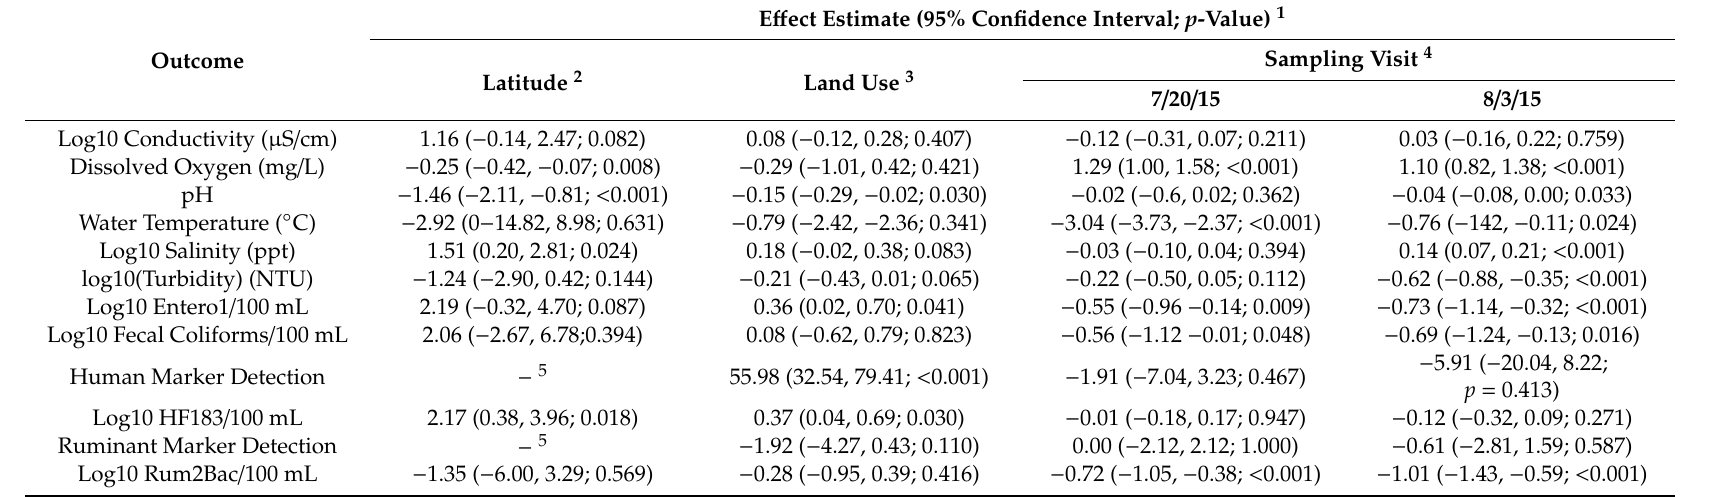
Table 3. Associations of microbial water quality parameters, FIB, and MST marker concentrations with latitude, land use, and sampling visit in Onondaga Creek. E ff ect Estimate (95% Confidence Interval; p -Value) 1 Outcome Latitude